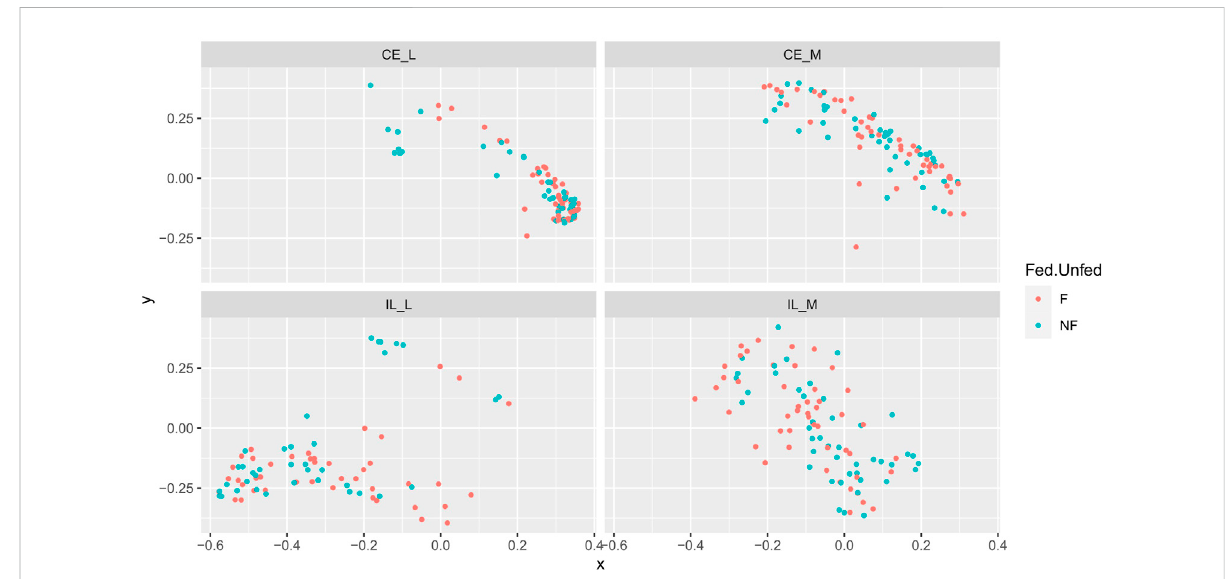
FIGURE 3 Comparison of beta-diversities. Principal coordinates analysis of Bray-Curtis matrices of fed and unfed samples at each site. Community structure was not signi fi cantly different among fed and unfed chicks at any site.